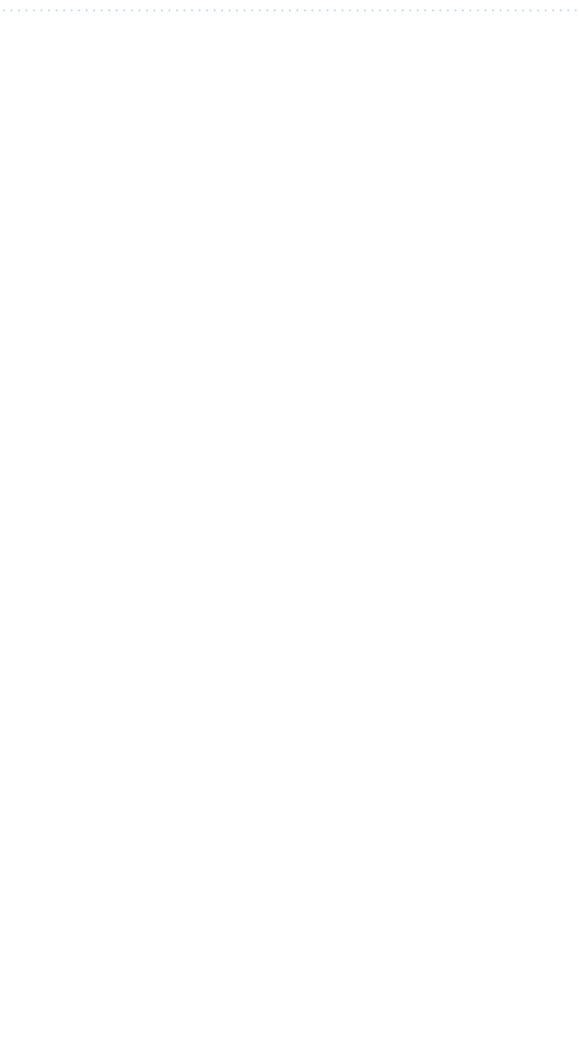
Figure 2. Bayesian network for Scenario 1 ‘certainty for psychological wellness’.